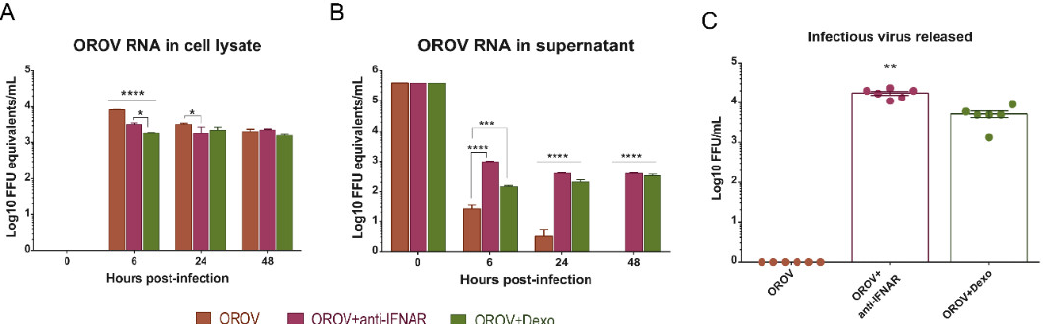
Figure 5. OROV infection and replication in PBMCs is favored when the type I IFN receptor is blocked and when the cells are treated with Dexamethasone. PBMC were pretreated for 2 h with Dexamethasone (Dexo) 1 µ M and human anti-IFNAR antibody 5 ng / mL, and infected with OROV at MOI 1. Cell lysates and supernatants were collected for analysis. ( A ) qRT-PCR of cell lysate and supernatant ( B ) for OROV RNA detection through the time of infection. Data were compared by two-way ANOVA and Tukey’s multiple comparison test. ( C ) Infectious particles released in the supernatant were measured by FFA, 48 hpi. Treatment groups were compared by one-way ANOVA and Dunn’s multiple comparisons test. Bars represent viral load ± SEM. **** p -value < 0.0001, *** p -value < 0.0007; and * p -value < 0.05.